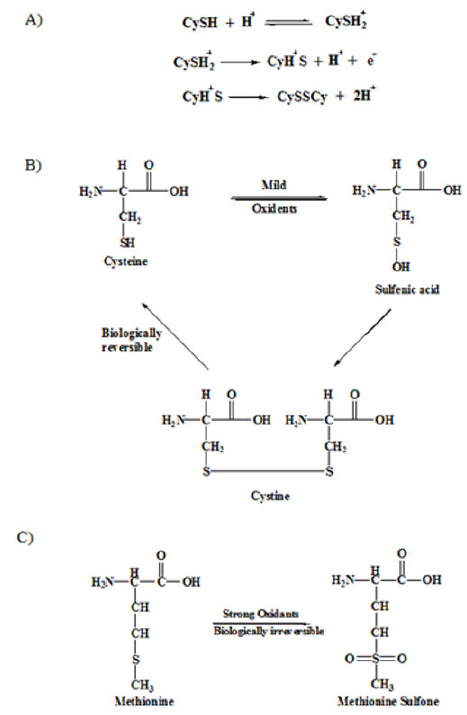
Figure 7. E ff ect of pH on the potential values and current height for ( a ) Cys and ( b ) Met. Scan rate: 50 mV /